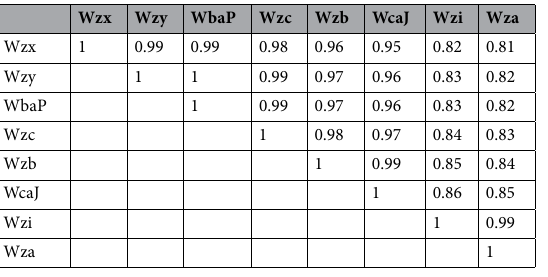
ARS correponding to the individual proteins in the reference dataset RRF = The highest ARS in the reference dataset